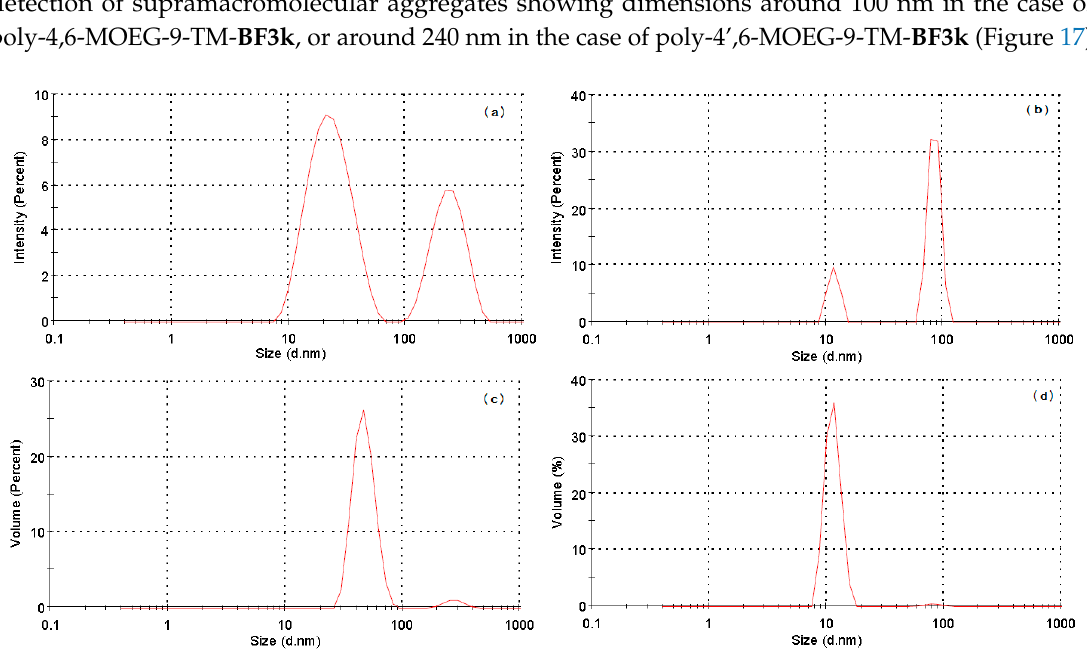
Figure 17. DLS size distribution histograms (by intensity a and b ; by volume c and d ) of poly-4’,6- MOEG-9-TM- BF3k ( a , c ) and poly-4,6-MOEG-9-TM- BF3k ( b , d ) dispersions in ultrapure